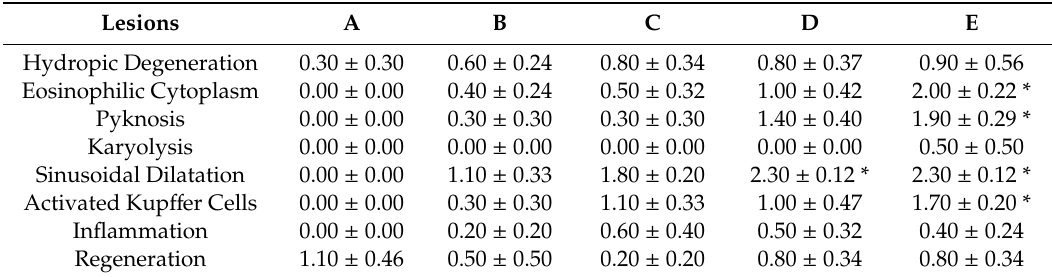
Lesions A B Hydropic